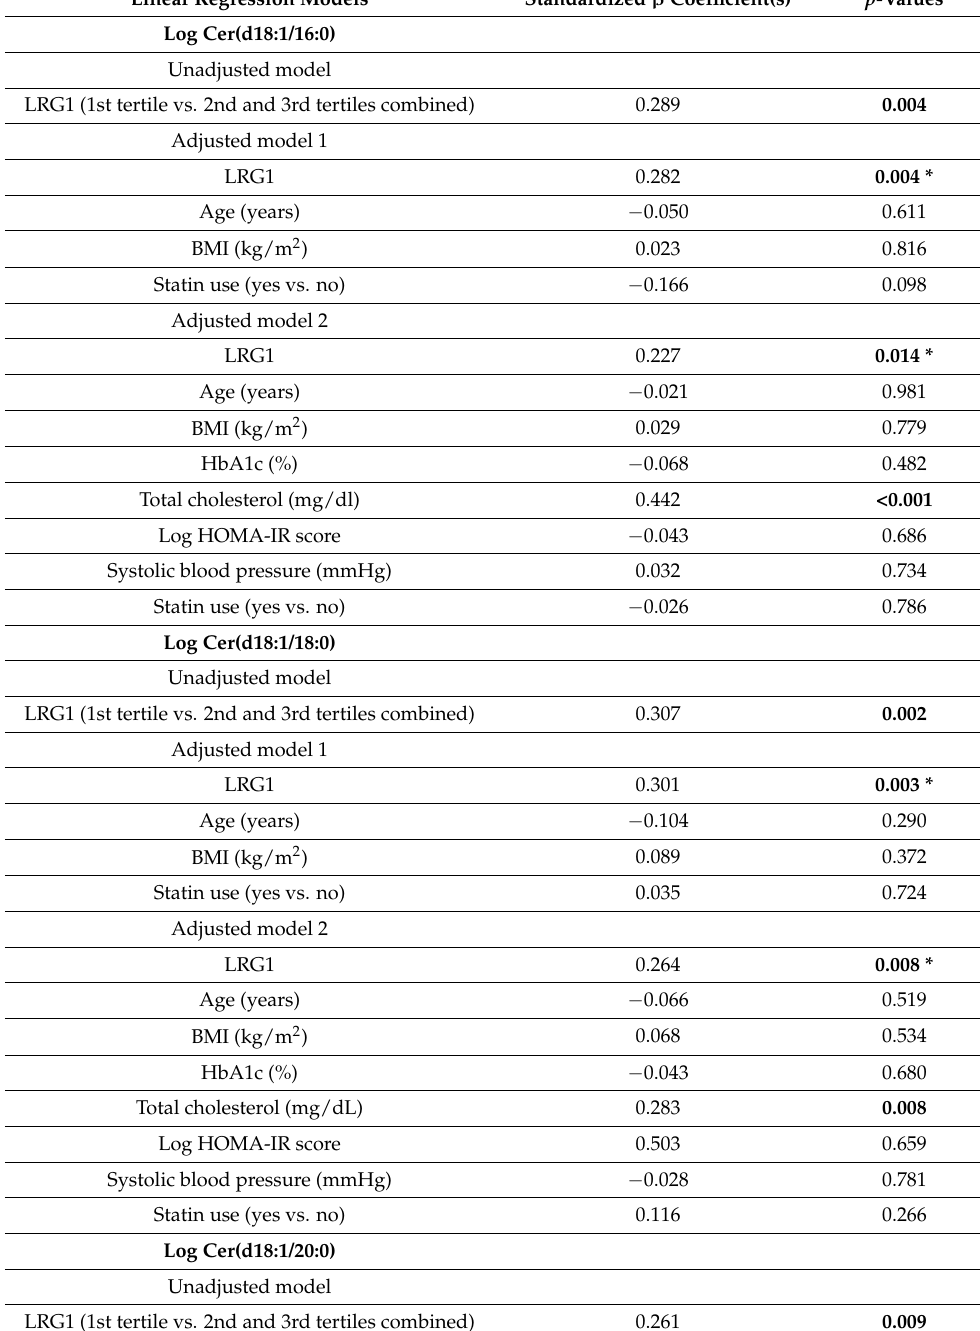
Table 2. Unadjusted and adjusted linear associations between each measured plasma ceramide and plasma LRG1 levels (included as 1st tertile vs. 2nd and 3rd tertiles combined) in postmenopausal women with non-insulin-treated T2DM. Linear Regression